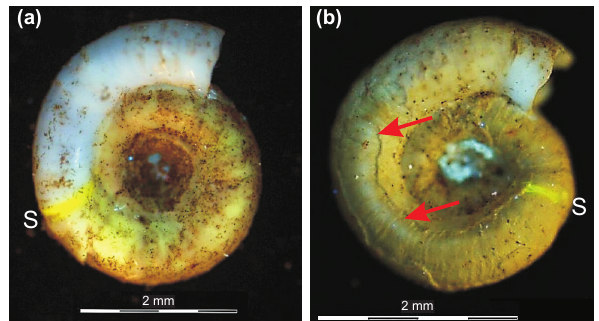
Figure 9. Pristine and corroded S. spirorbis shells. (a) Pristine smooth surface without visible corrosion. Specimen from winter control experiment. (b) Corroded surface of a tube from winter + CO + T experiment. The outermost shell layer was removed by 2 corrosion, exposing the ring structure of the underlying shell layer (arrows). “S” indicates position of the stain line (start of experi- ment). Note that the specimen in (a) had a larger initial diameter than the specimen in (b) , but grew a shorter new tube segment dur- ing the